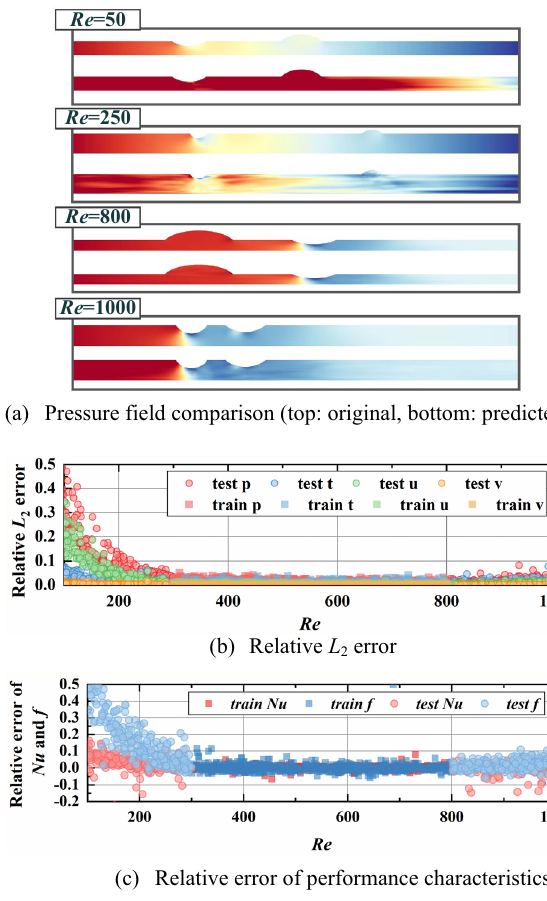
Figure 12. Extrapolation performance of